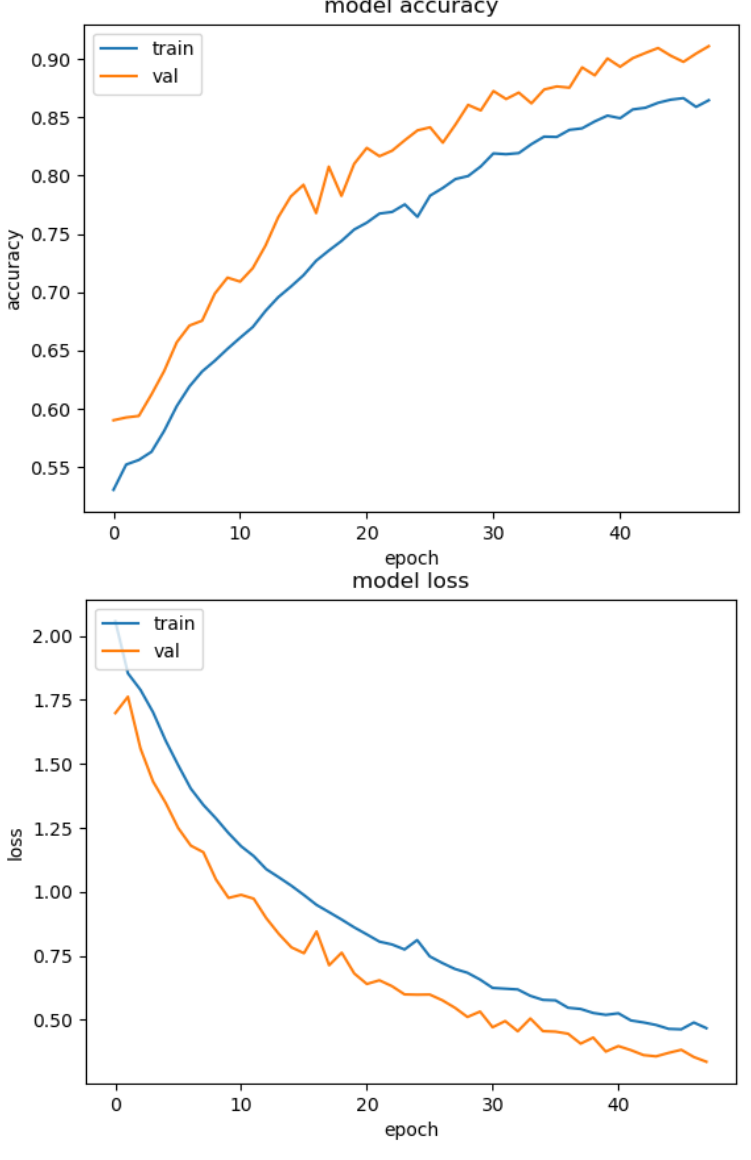
Figure 2. Autoencoder accuracy per epoch ( top ) and lost per epoch ( bottom ) for the 1st fold training phase. As with the DNN classification models of Section 5.4.1, the CNN had the same